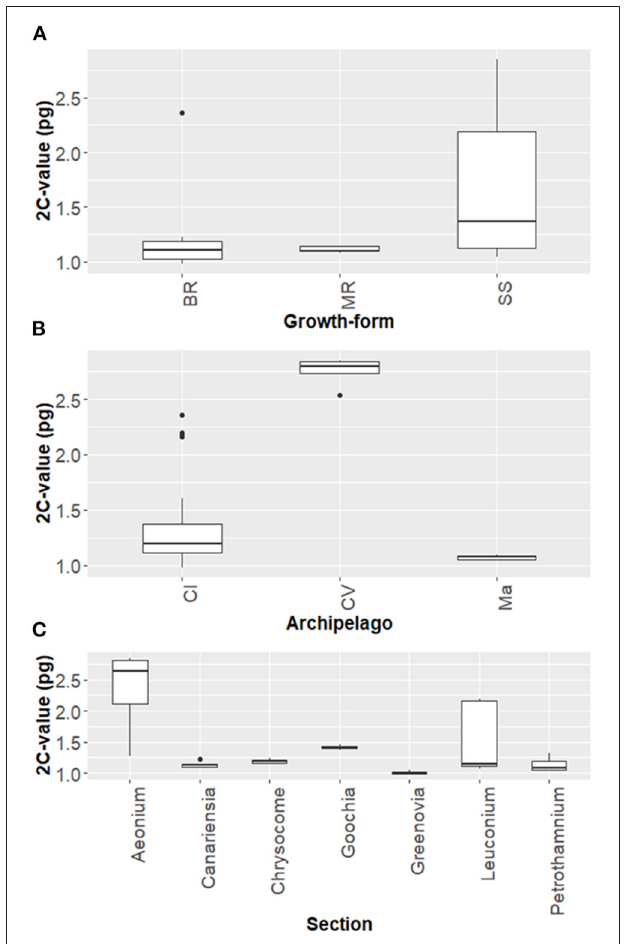
FIGURE 6 | Boxplot diagram showing the genome size variation across 24 Aeonium species according to: (A) Growth-form (BR, Branching rosette; MR, Monocarpic rosette; SS, Subshrub); (B) Archipelago (CI, Canary Islands; CV, Cabo Verde; Ma, Madeira); and (C) Section; The gray box represents the 25th, 50th (median), and 75th percentiles, while whiskers represent the 10th and 90th percentiles with minimum and maximum observations. The black dots represent the outliers. Boxplots show 25th and 75th percentile, while error bars 1st and 99th percentile.